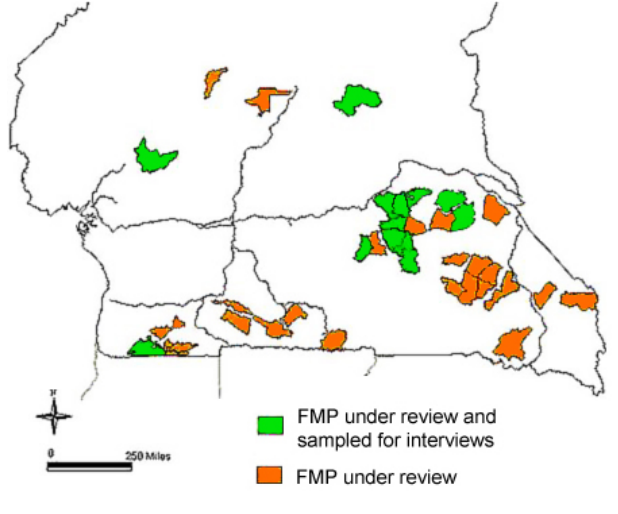
Fig. 1 . Sample of logging concessions under